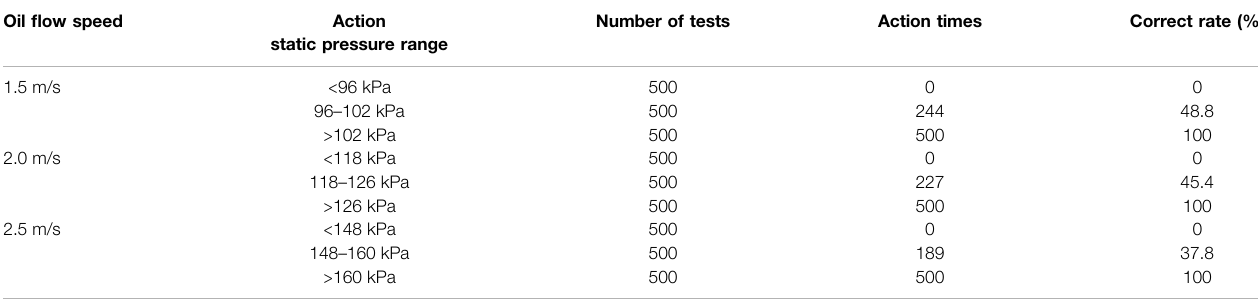
TABLE 5 | Results of oil fl ow relay static pressure